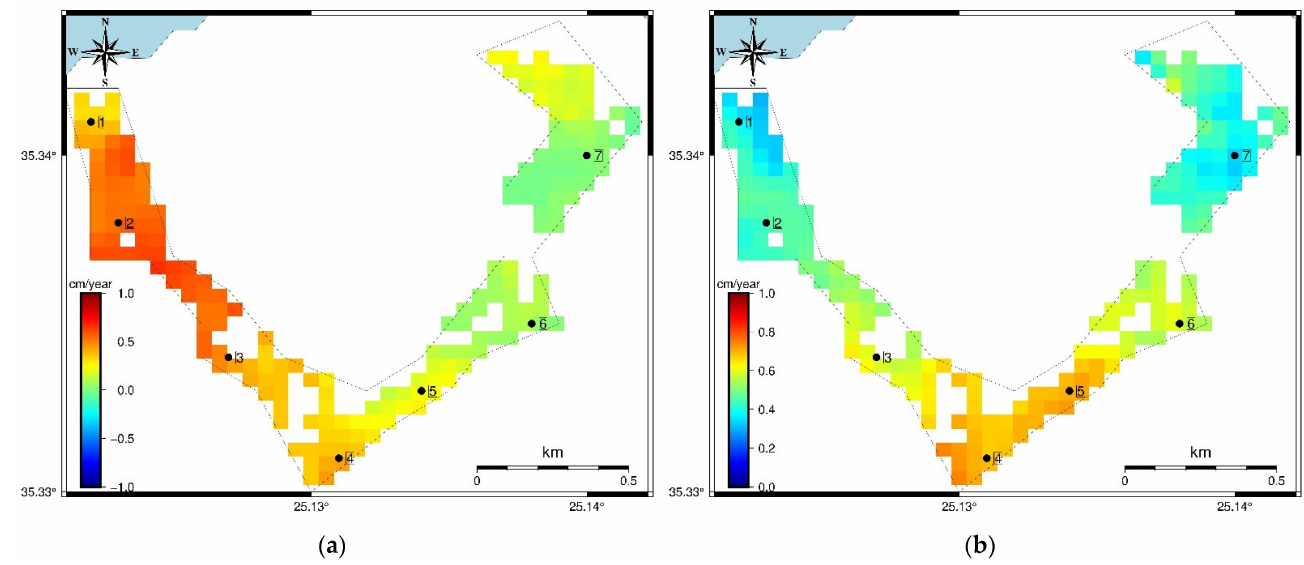
Figure 9. Two-dimensional deformation rates at the HCW site, the 7 black dots represent the 7 bastions as in Figure 2. ( a ) EW deformation rates, positive to the east; ( b ) UD deformation rates, positive